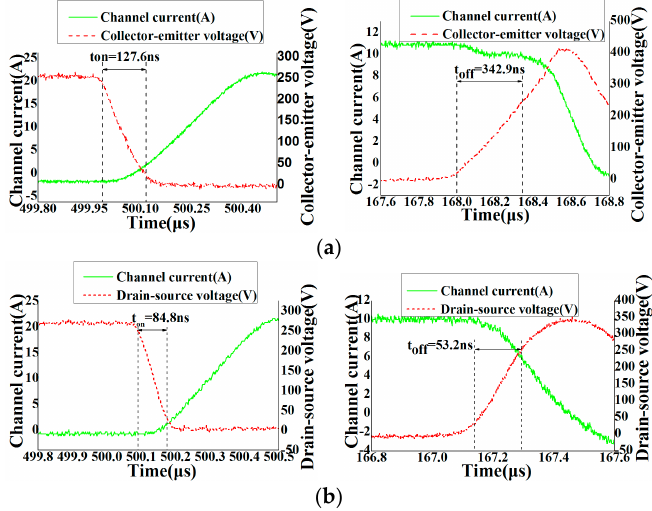
Figure 3. Turn-on and turn-off trajectories. ( a ) Si IGBT; ( b ) SiC MOSFET.